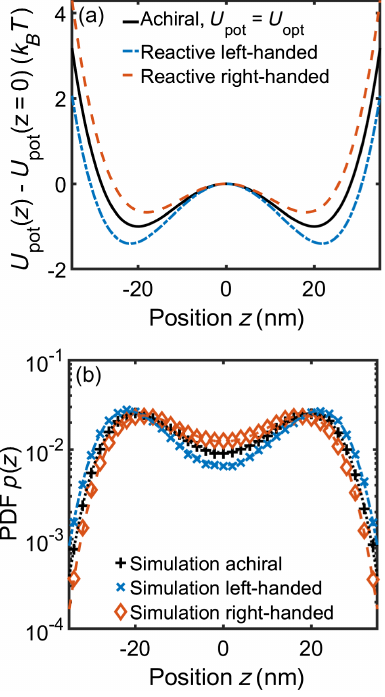
FIG. 6. (a) With h þ ¼ h − and the polarization settings of the two beams detailed in Fig. 3, the chiral coupling is reactive, leading to conservative chiral optical forces exerted on the chiral dipolar nanosphere ( χ = α ¼ 5% ) diffusing within the bistable optical trap. Because these forces derive from a chiral potential U ð q; z Þ , they combine with the achiral electromagnetic χ ð q; z Þ . The potential to form the potential energy surface U pot resulting potentials at q ¼ 0 are plotted for the two opposite enantiomers: the right-handed (Re ½ χ (cid:3) > 0 in red) and the left- handed one (Re ½ χ (cid:3) < 0 in blue). The same is plotted in black for an achiral environment. The same differences would be induced for one fixed choice of enantiomer but using two opposite enantiomorphs for the reactive chiral optical field. (b) The corresponding normalized PDFs are evaluated from our one- dimensional model (lines) and three-dimensional simulations (symbols) as detailed in Appendix E. Although the achiral and chiral PDFs appear only slightly different, their enantioselec- tive character is manifest, revealing a chiral discriminating